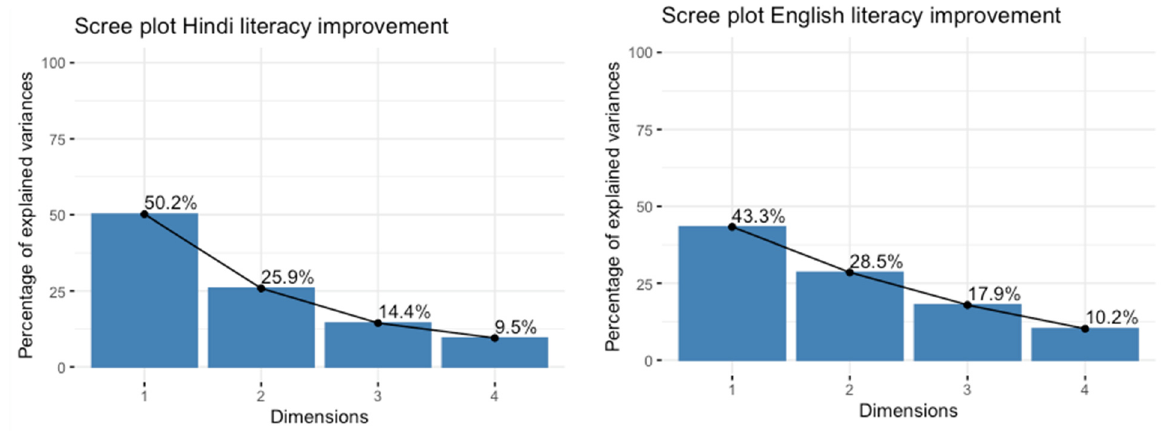
Figure A3. Scree plots of the principal components analysis for the literacy data.